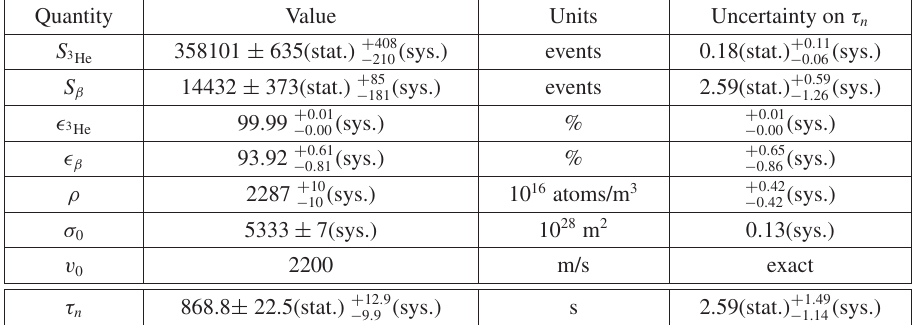
Table 3. Result of a single neutron lifetime run and list of parameters entering Eq. (1) for analysis (very preliminary). Experimental data were taken in 2016. The last column describes the respective contribution of each quantity to the uncertainty on τ n .